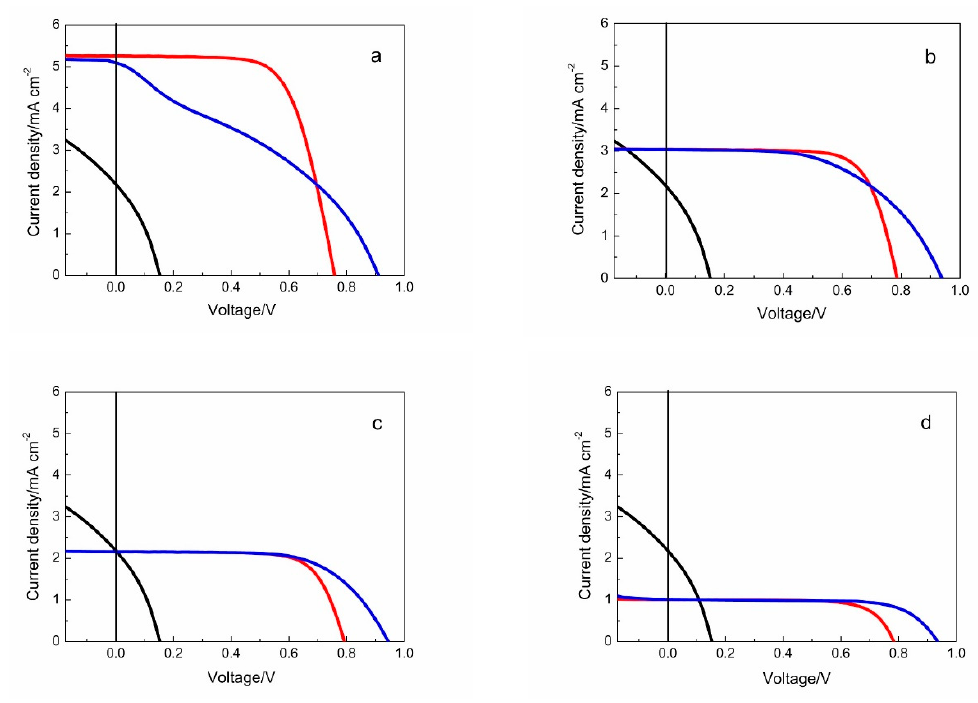
Figure 4. J-V curves of the calculated pn-DSC (blue line) as well as the corresponding n-DSC (red line) and p-DSC (black line). ( a ) Pn-DSC with a high performance photoanode and the photocathode; ( b ) Jsc of n-DSC in the range from Jsc to the threshold photocurrent density of the p-DSC; ( c ) Photocurrent of the two photocathode are well matched; ( d ) Jsc of the n-DSC lower than that of p-DSC. Table 1. Photovoltaic parameters of the calculated pn-DSCs as well as p-DSCs and n-DSCs. Condition